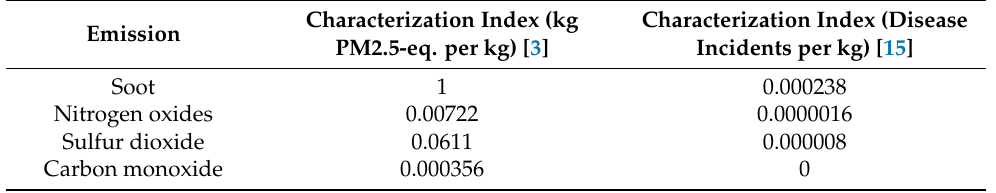
Table 3. Characterization indices for emissions per kg fuel for air transport related to Particulate Matter and Respiratory Inorganics impact